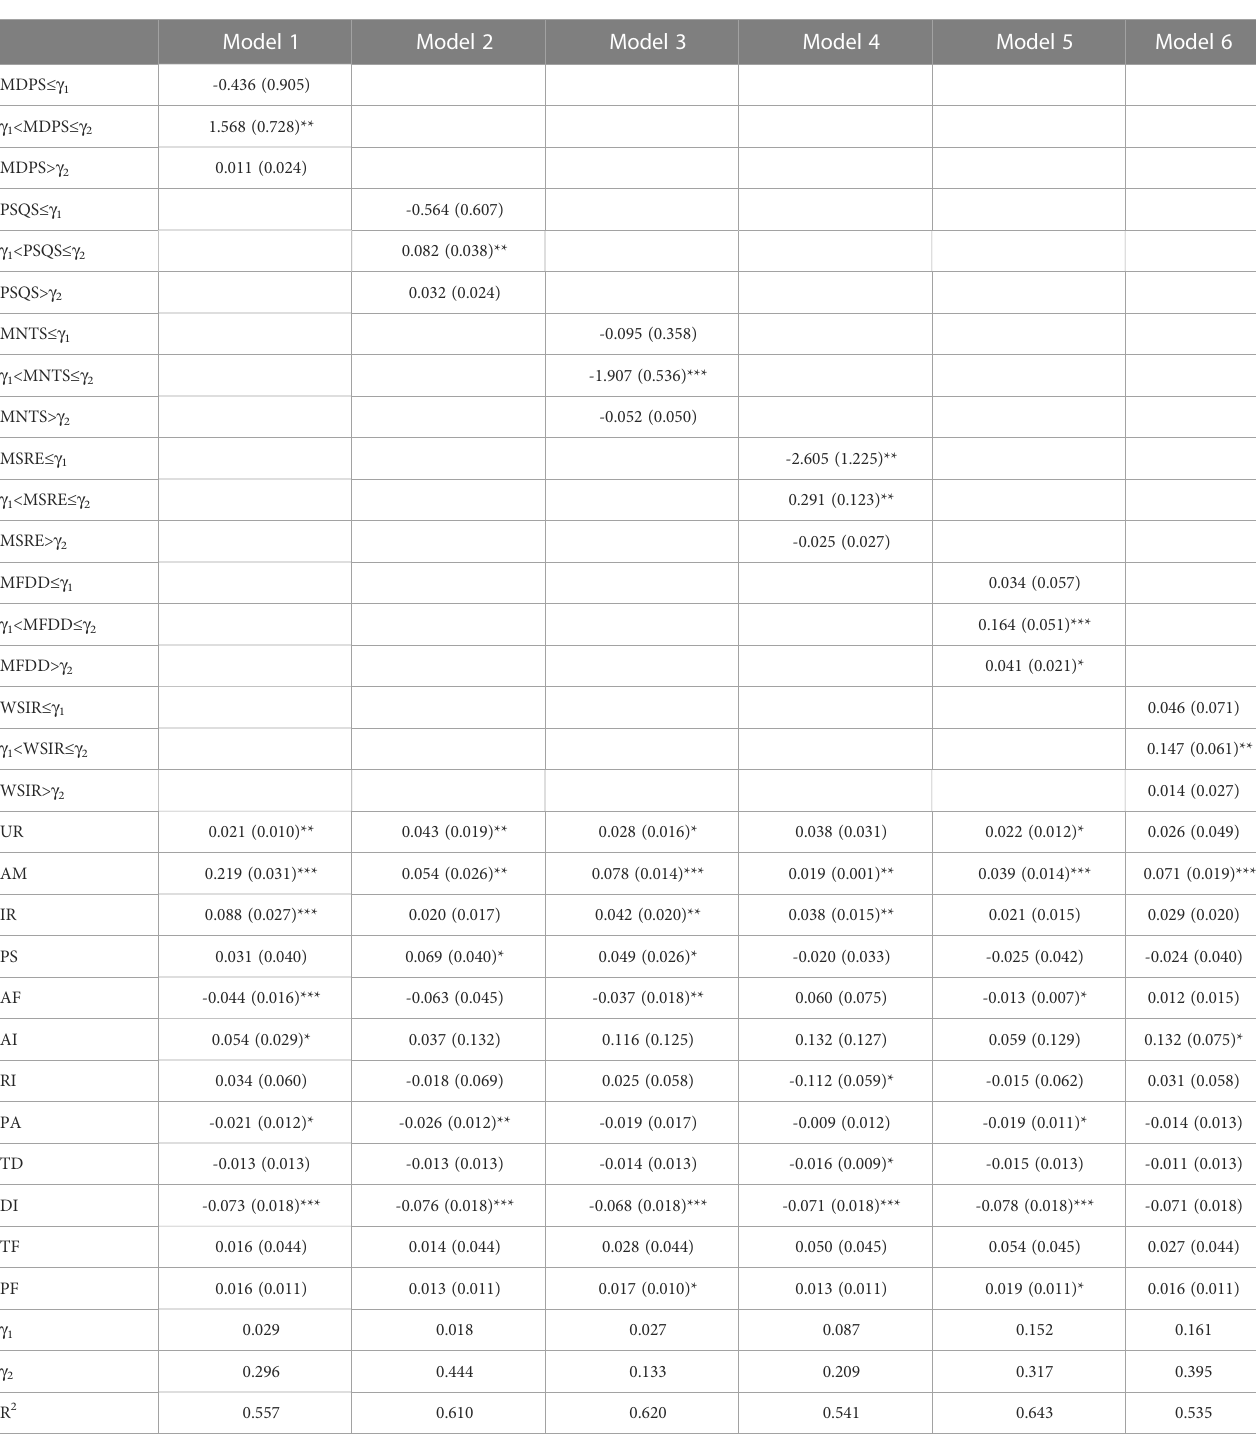
TABLE 1 The threshold model results of GTFPG in the whole